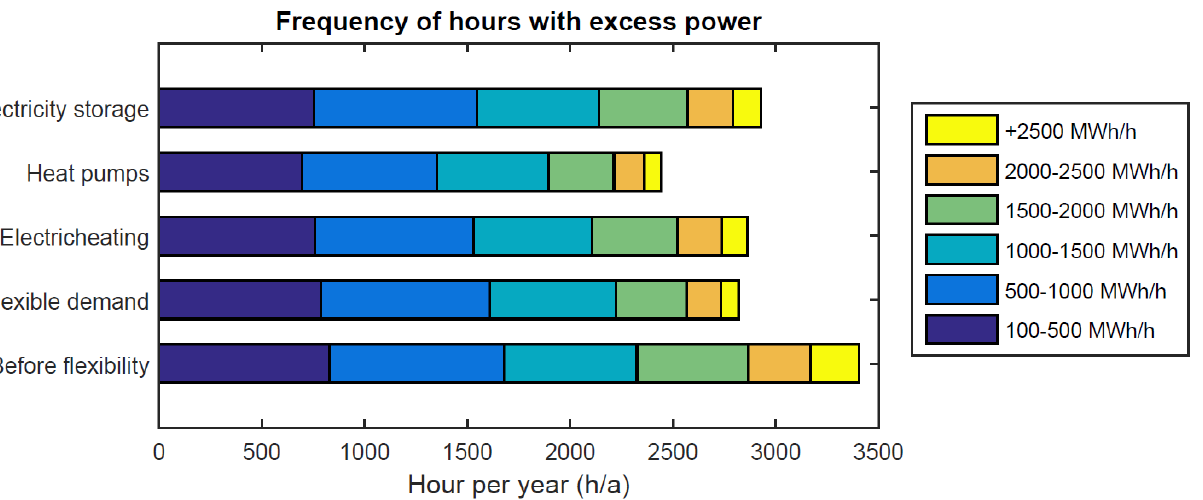
Figure 14. Comparing the frequency and magnitude of excess power before and after employing 300 MW e of flexible technologies (conditions for Case I, see Table